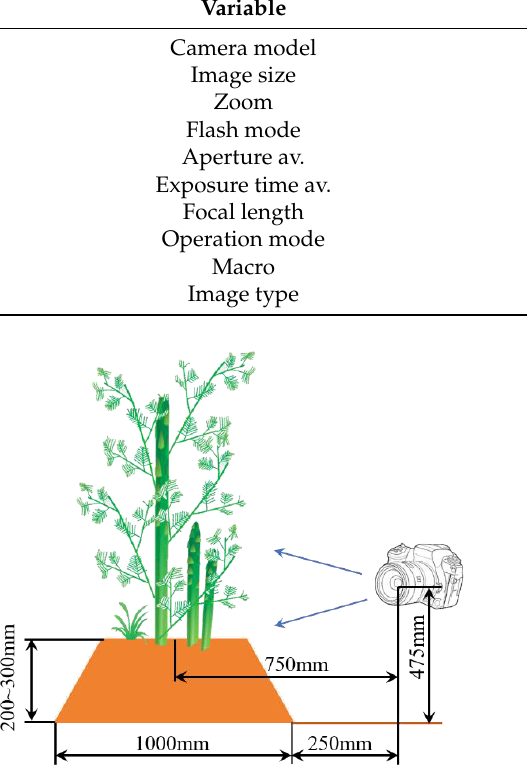
Figure 1. Image Figure 1. Image acquisition.